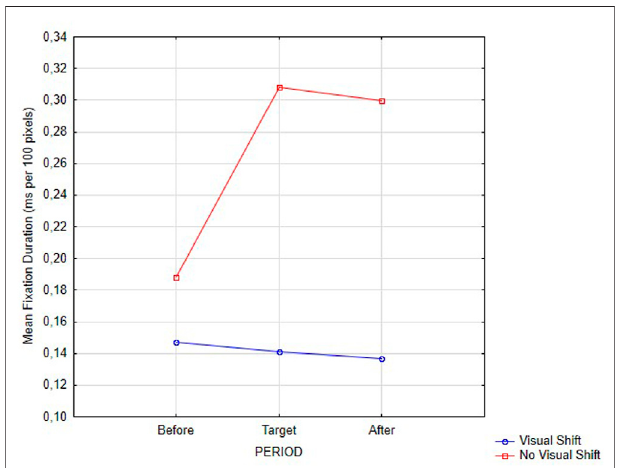
FIGURE3| Signi fi cantinteractionbetween period (Before, Target,After) and VISUAL perspective shift (Visual Shift, No Visual Shift).